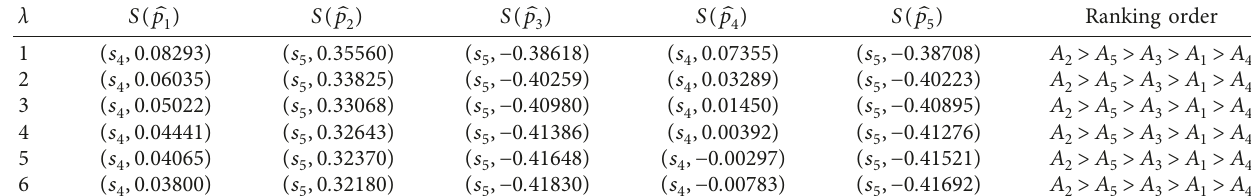
Table 8: Score values by varying λ based on the 2TLmFHWA operator.